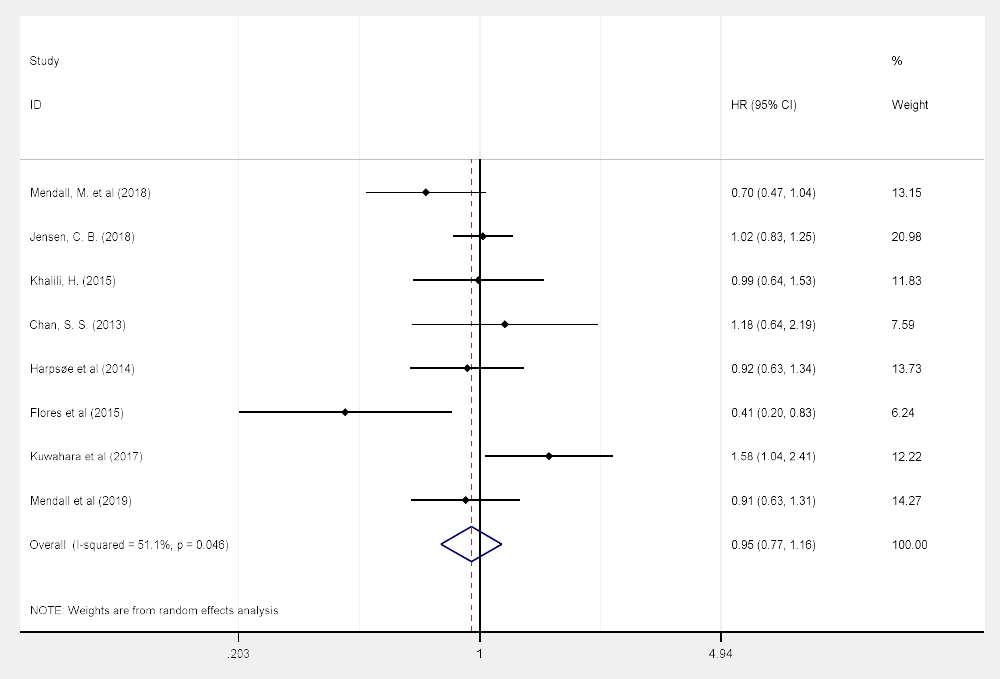
Figure 8. Dose–response association between BMI and development of ulcerative colitis.